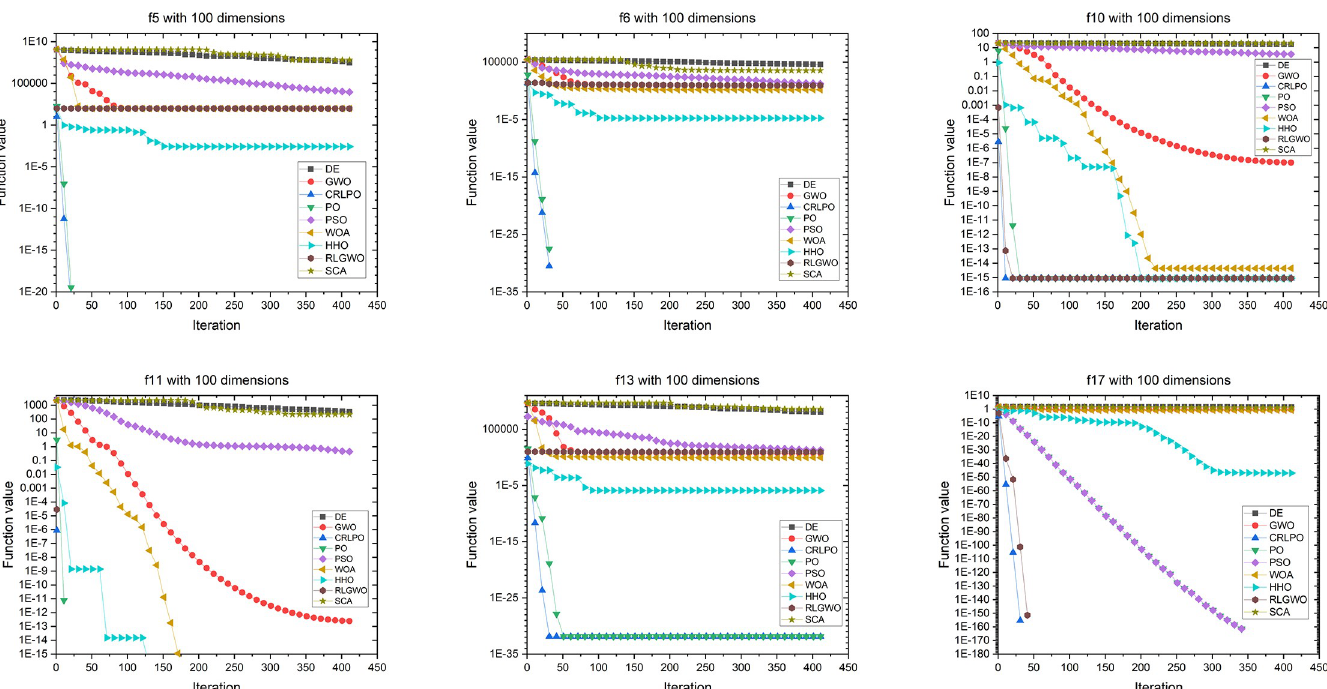
Fig 15. Convergence graph of CRLPO as well as eight other algorithms on six representative benchmark functions with 100 dimensions.